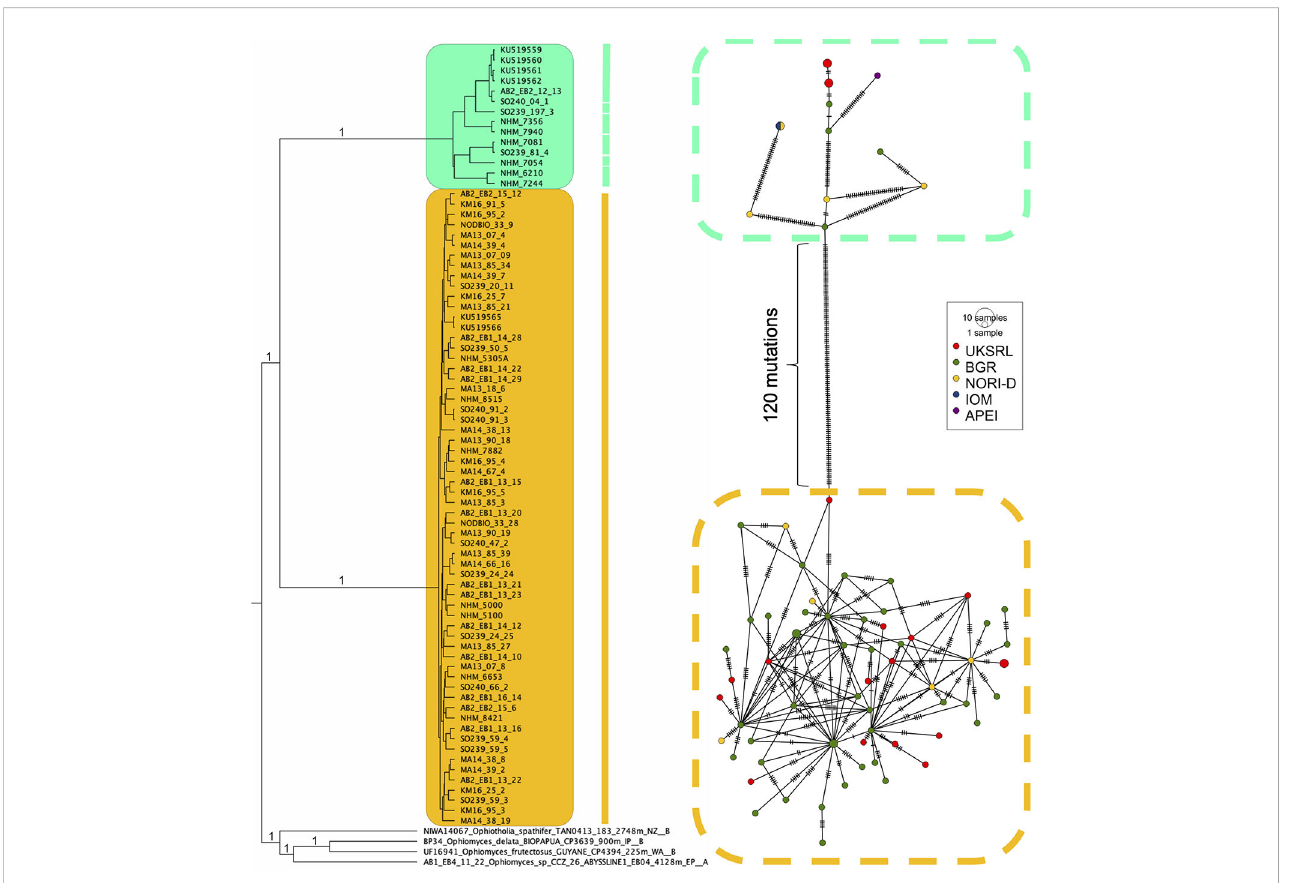
FIGURE 12 Ultrametric tree resulting from the Bayesian analysis of the CCZOTHOL dataset. The posterior support ( ≥ 99%) is indicated at the branch. The results of both species delimitation analyses (BINs, GMYC), are shown through the bar. The tree is combined with the haplotype network of Ophiotholia saskia sp. nov. and Ophiotholia supplicans ; produced by PopART (Leigh and Bryant, 2015). The haplotype network is based on COI data of 75 samples. The size of the circle indicates the number of haplotypes. The colours are assigned to the different areas in the CCZ (red = UKSRL; green = BGR; yellow = NORI-D, blue = IOM, violet = APEI). The dashed boxes around each subnetwork indicate the morphological clusters in the Neighbour-Joining tree (Turquoise = Ophiotholia supplicans ; Yellow= Ophiotholia saskia